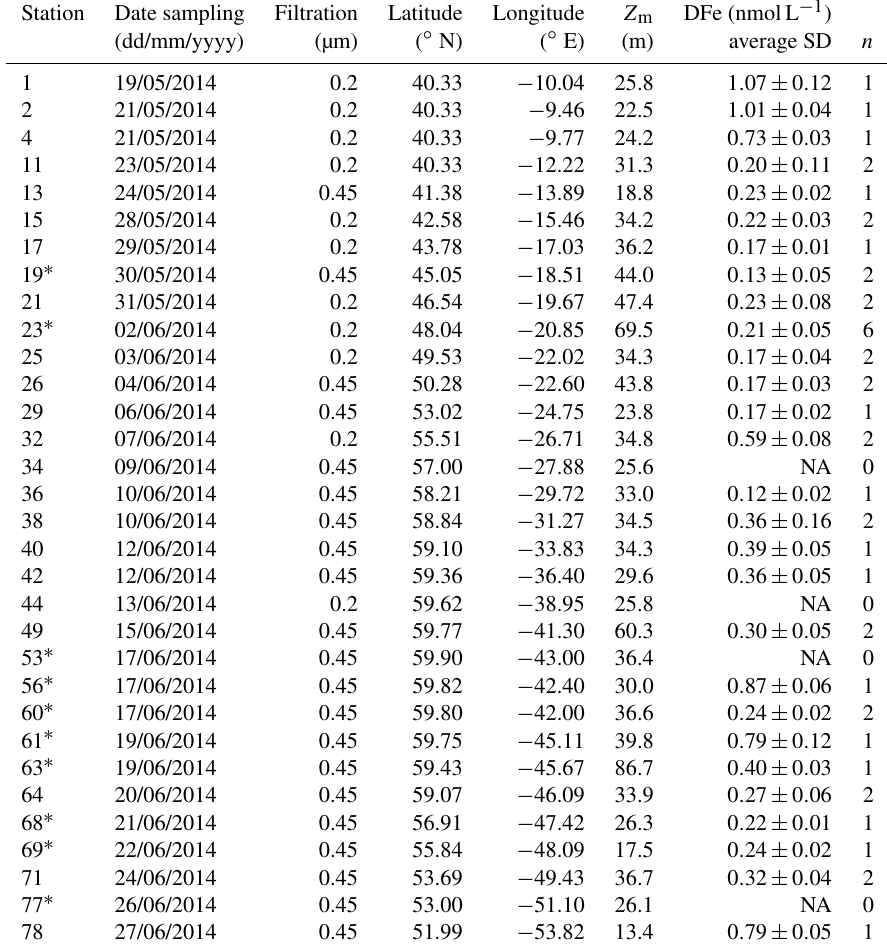
Table 1. Station number, date of sampling (in the dd/mm/yyyy format), pore size used for filtration (µm), station location, mixed-layer depth (m), and associated average dissolved iron (DFe) concentrations, standard deviation, and number of samples during the GEOTRACES GA01 transect. Note that the asterisk next to station numbers refers to disturbed temperature and salinity profiles as opposed to uniform